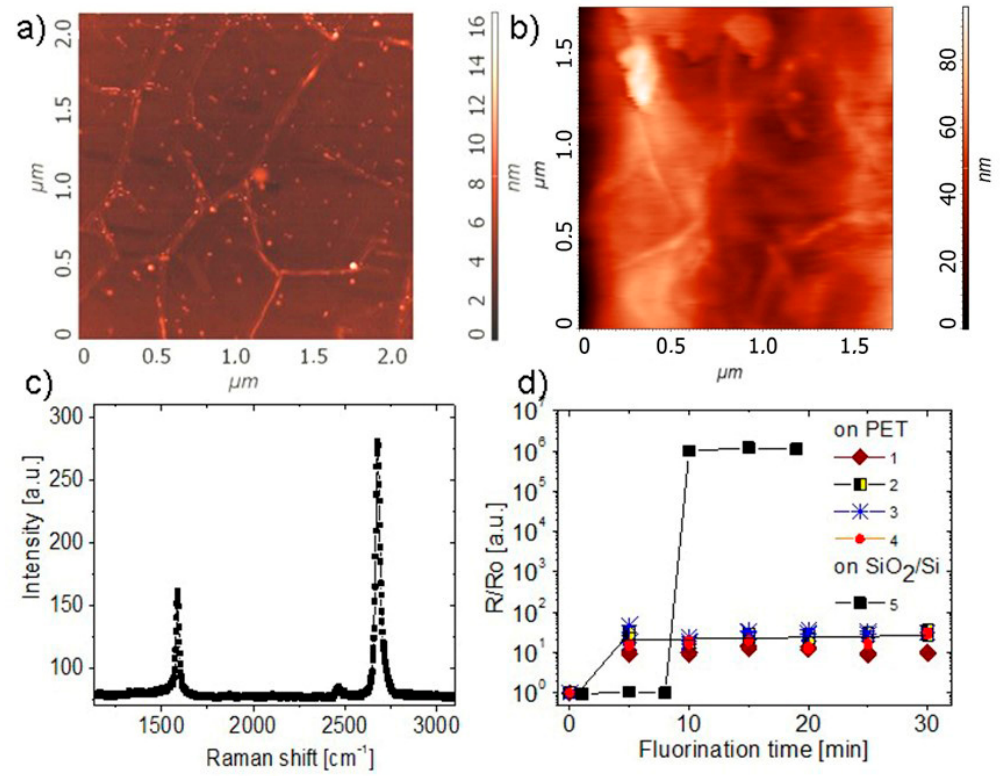
Figure 1. ( a , b ) Atomic force microscopy (AFM) images of CVD-grown graphene films transferred to the SiO 2 / Si and PET substrates ( c ) The Raman spectra for graphene on SiO 2 / Si substrate. ( d ) Resistivity as a function of fluorination time for few (1–4) structures on PET and one structure on SiO 2 / Si substrates for comparison. R o for both graphene samples was ~900 Ohm / sq.